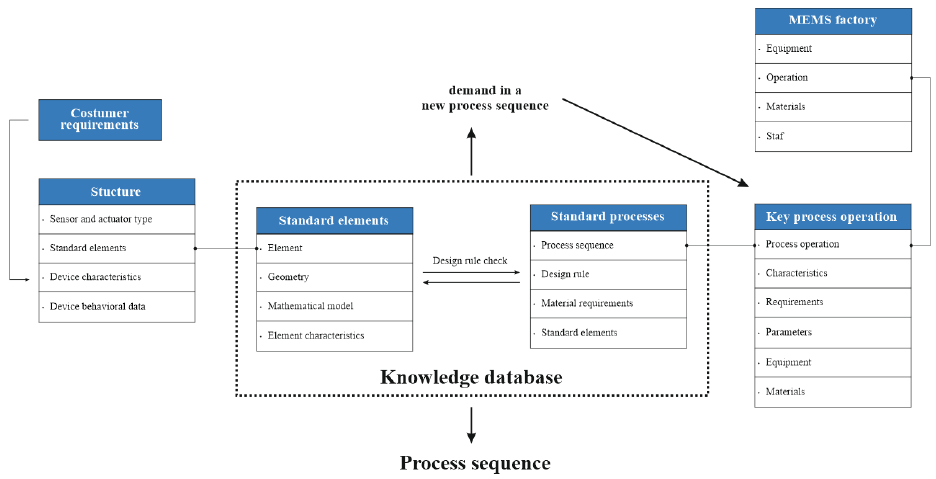
Fig. 13. Key elements of the MEMS digital modeling knowledge